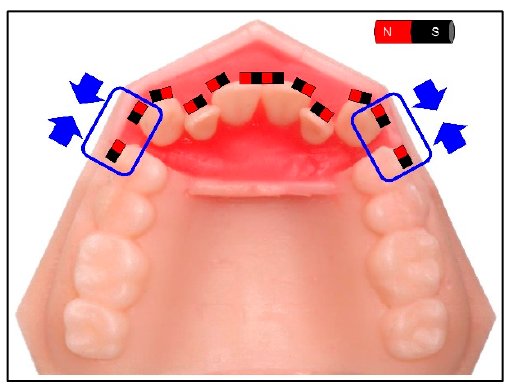
Figure 4. The magnet settings on the model of a moderate crowding case. Canines are supposed to move distally by magnetic force.